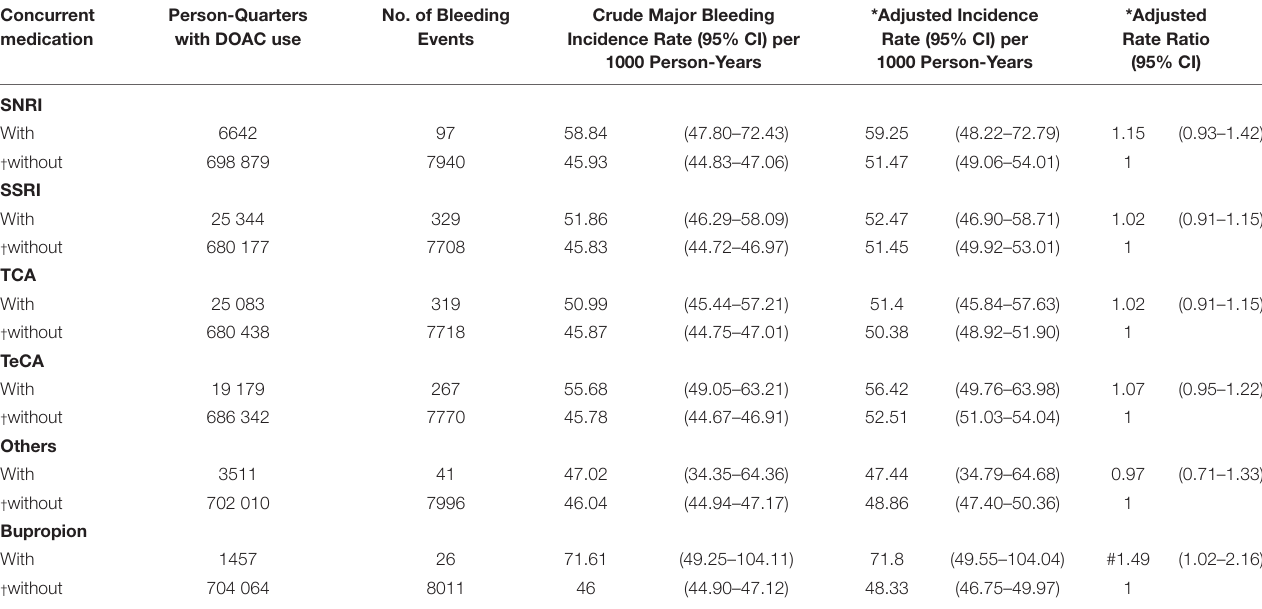
TABLE 3 | Major bleeding risk among patients with atrial fibrillation (AF) taking DOACs with or without concurrent antidepressants. Concurrent Person-Quarters medication with DOAC use